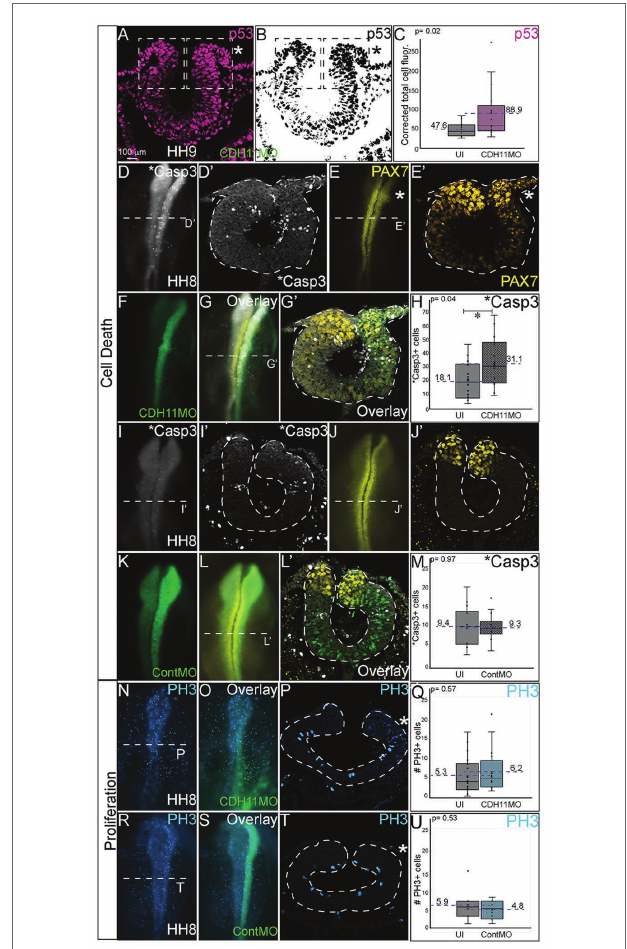
FIGURE 4 | Loss of CDH11 increases cell death. To determine the cause of reduced NC cell population after CDH11 knockdown, IHC was performed for (A-C) p53, (D,D’,G,G’,I,I’,L,L’) activated caspase 3 (*Casp3) to mark apoptotic cells, (E,E’,G,G’,J,J’,L,L’) PAX7, or (N–U) phosphorylated histone H3 (PH3) to mark mitotic cells. (A,B) IHC for p53 in transverse section. (C) Graph showing difference between fluorescence intensity on uninjected and CDH11MO- injected sides ( n = 17, p = 0.02). (D) IHC for *Casp3 or (E) PAX7 in whole mount or for (D’) *Casp3 or (E’) PAX7 in transverse section, (F) CDH11MO in whole mount and (G,G’) are overlays. (H) Graph showing increased number of *Casp3-positive cells on CDH11MO side. Mean number *Casp3+ apoptotic cells is 17.90 on uninjected and 31.86 on CDH11MO-injected side, n = 14, p = 0.04. (I) IHC for *Casp3 or (J) PAX7 in whole mount or for (I’) *Casp3 or (J’) PAX7 in transverse section, (K) ContMO in whole mount and (L,L’) are overlays. (M) Graph showing difference between uninjected and ContMO-injected sides. Mean number of *Casp3+ apoptotic bodies is 9.36 on uninjected and 9.36 on ContMO-injected side, p = 0.97, n = 14. (N) IHC for PH3 in whole mount and (O) overlay with CDH11MO. (P) Transverse section from HH8 embryo injected with CDH11MO on right side (green). (Q) Graph showing difference between uninjected and CDH11MO-injected sides. Mean number of PH3+ cells is 6.20 on uninjected and 5.20 on CDH11MO-injected side, p = 0.50, n = 20. (R) IHC for PH3 in whole mount embryo injected with (S) ContMO. (T) Transverse section. (U) Graph showing difference between uninjected and ContMO- injected sides. Mean number of PH3+ cells is 5.88 on uninjected and 4.75 on ContMO-injected side, p = 0.54, n = 8. Loss of CDH11 increases cell death on injected side. All graphs show mean (indicated on graph) and median (line within graph). Scale bar whole mount images indicated in (A) and for sections in (C) . Asterisk indicates injected side in